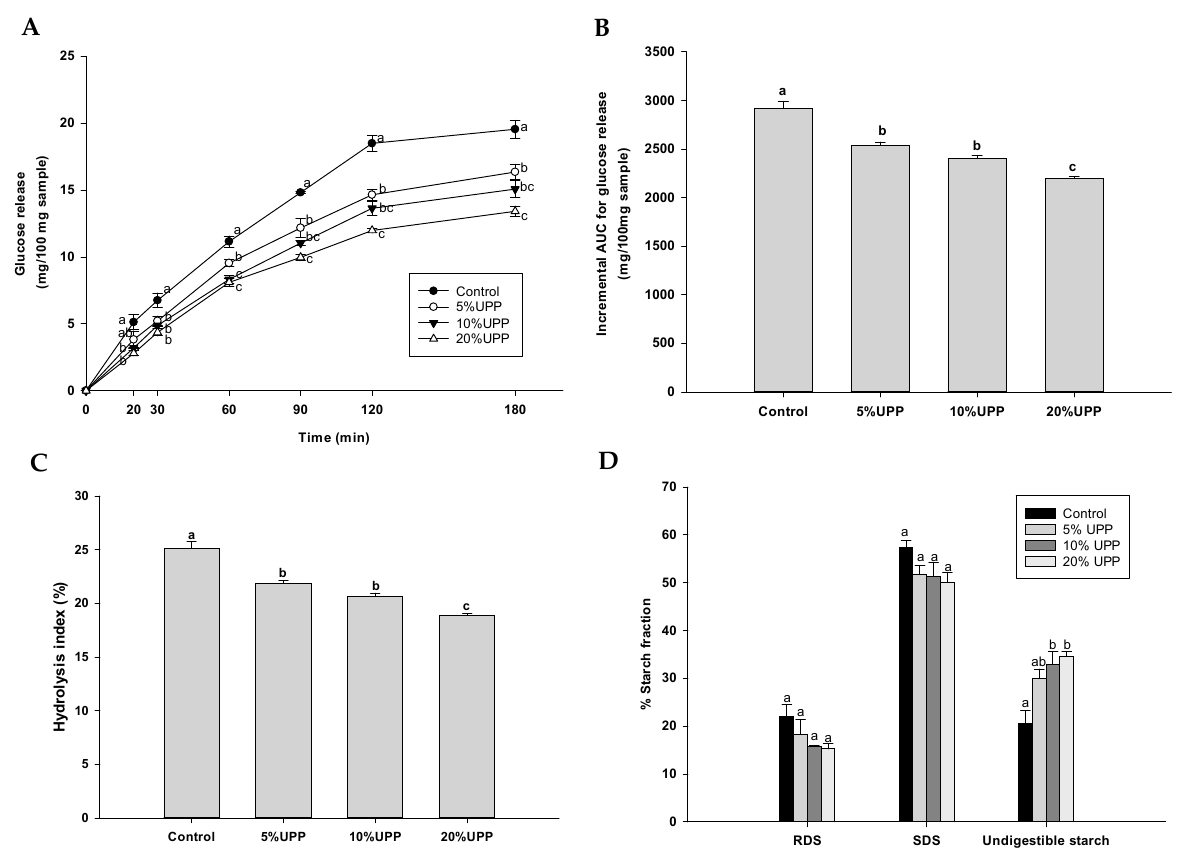
Figure 3. The effect of UPP replacement in pancakes on ( A ) starch digestibility, ( B ) the incremental area under the curves (iAUCs) for glucose release, ( C ) hydrolysis index and ( D ) the percentage of starch fraction including rapidly digestible starch (RDS), slowly digestible starch (SDS) and undigestible starch. Data are expressed as mean ± SEM, n = 3. Values with different letters in each column are significantly different ( p < 0.05).